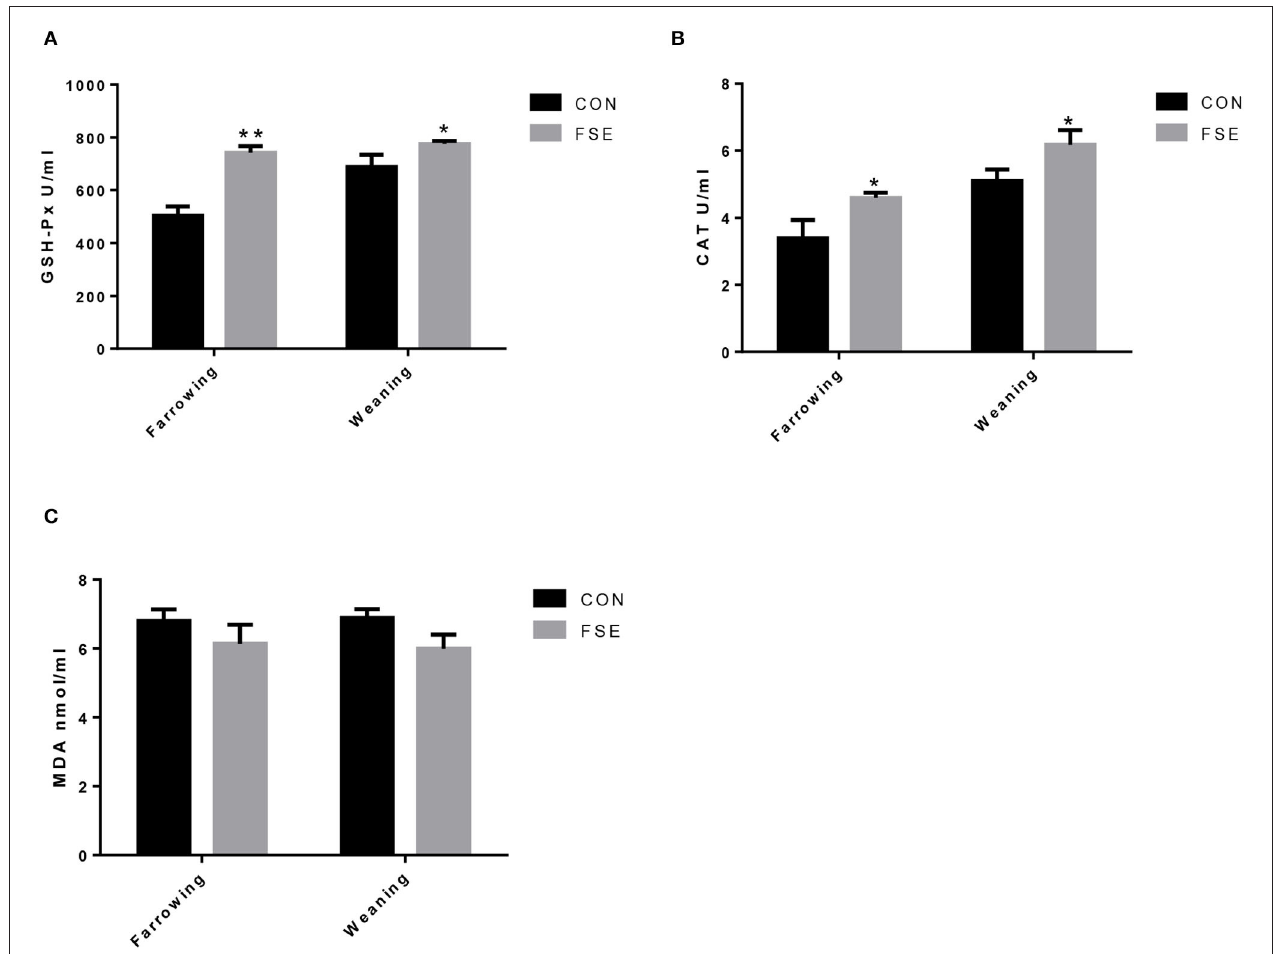
FIGURE 1 | Effects of Forsythia suspensa extract on serum antioxidant status of lactating sows. CON, control treatment; FSE, Forsythia suspensa extract treatment; (A) GSH-Px, glutathione peroxidase; (B) CAT, catalase; (C) MDA, malondialdehyde. All values are expressed as means ± SEM ( n = 12). * P < 0.05, ** P <